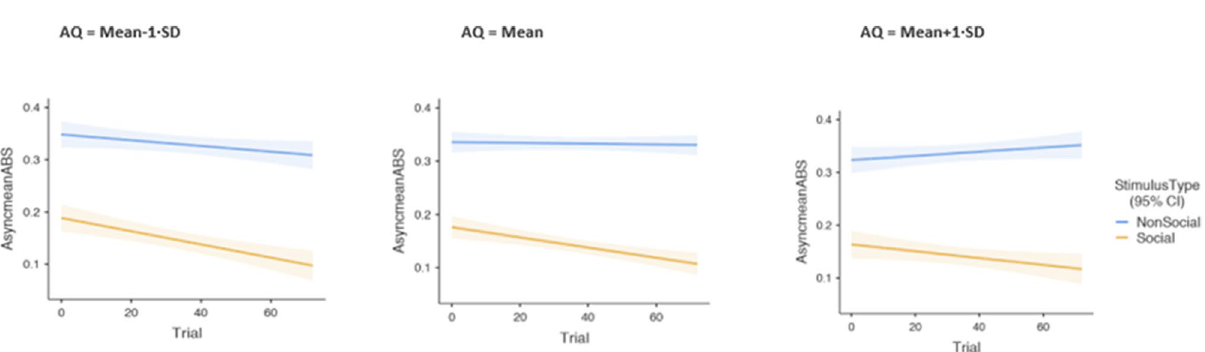
asynchrony in seconds. The error bars signify a 95% confidence